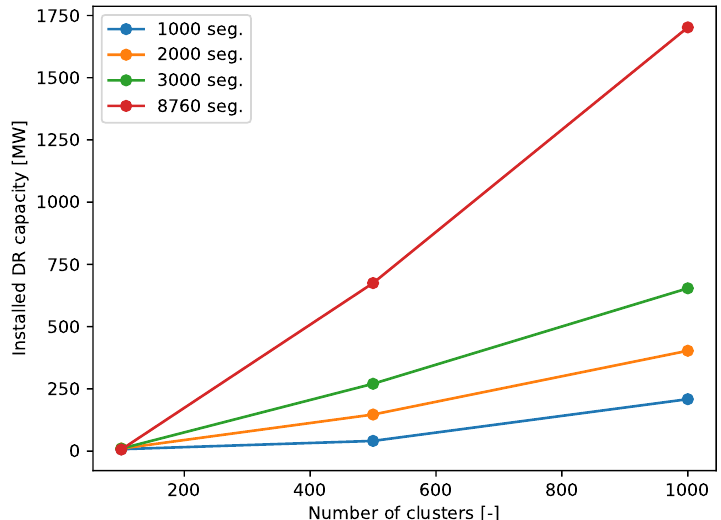
Figure 16. Influence of the number of grid node clusters and the number of time segments on the installed DR capacity. For the case of 8760 segments (full temporal resolution), the optimisation was carried out on a weekly basis, see Section